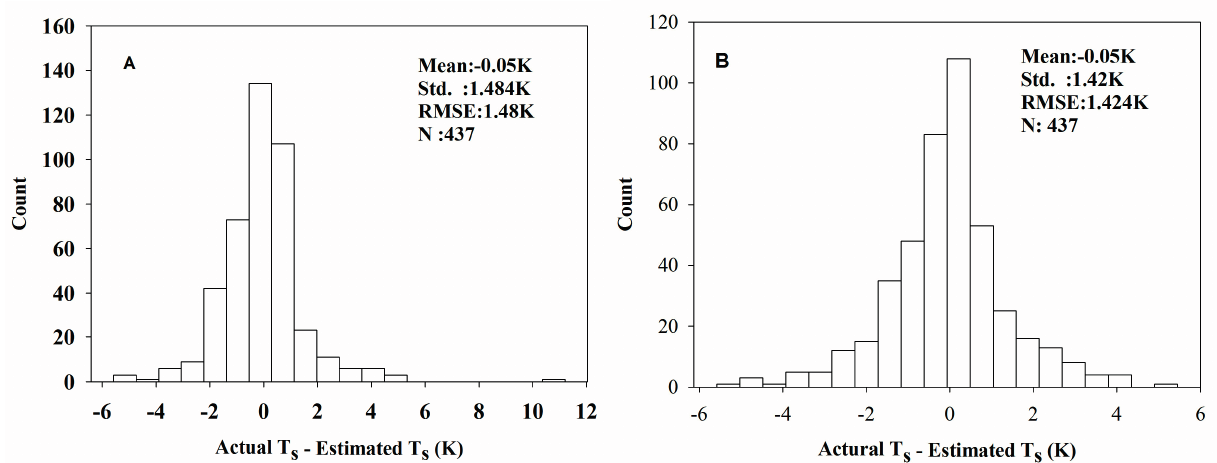
Figure 6. Histogram of errors in the measured T cloud and in the estimated T cloud based on adding biases to T clear (( A ): add a − 0.25 K bias; ( B ): add a − 0.5 K bias; ( C ): add a 0.25 K bias; and ( D ): add a 0. 5 K